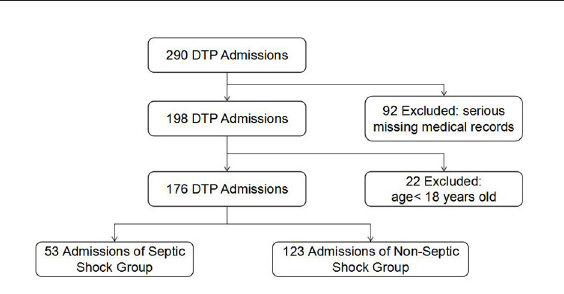
FIGURE1 Flowchart of DTP cohorts analyzed showing the inclusion and exclusion criteria. DTP, digestive tract